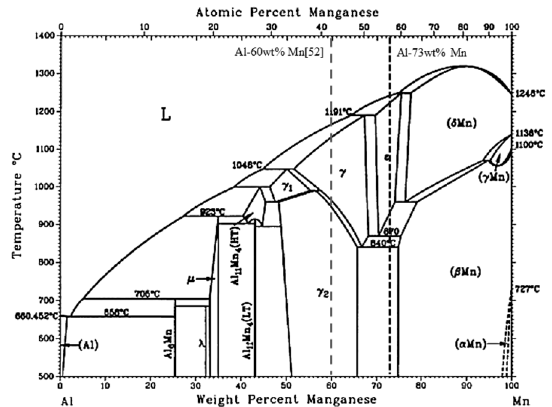
Figure 8. Equilibrium phase diagram of binary Al–Mn [35].